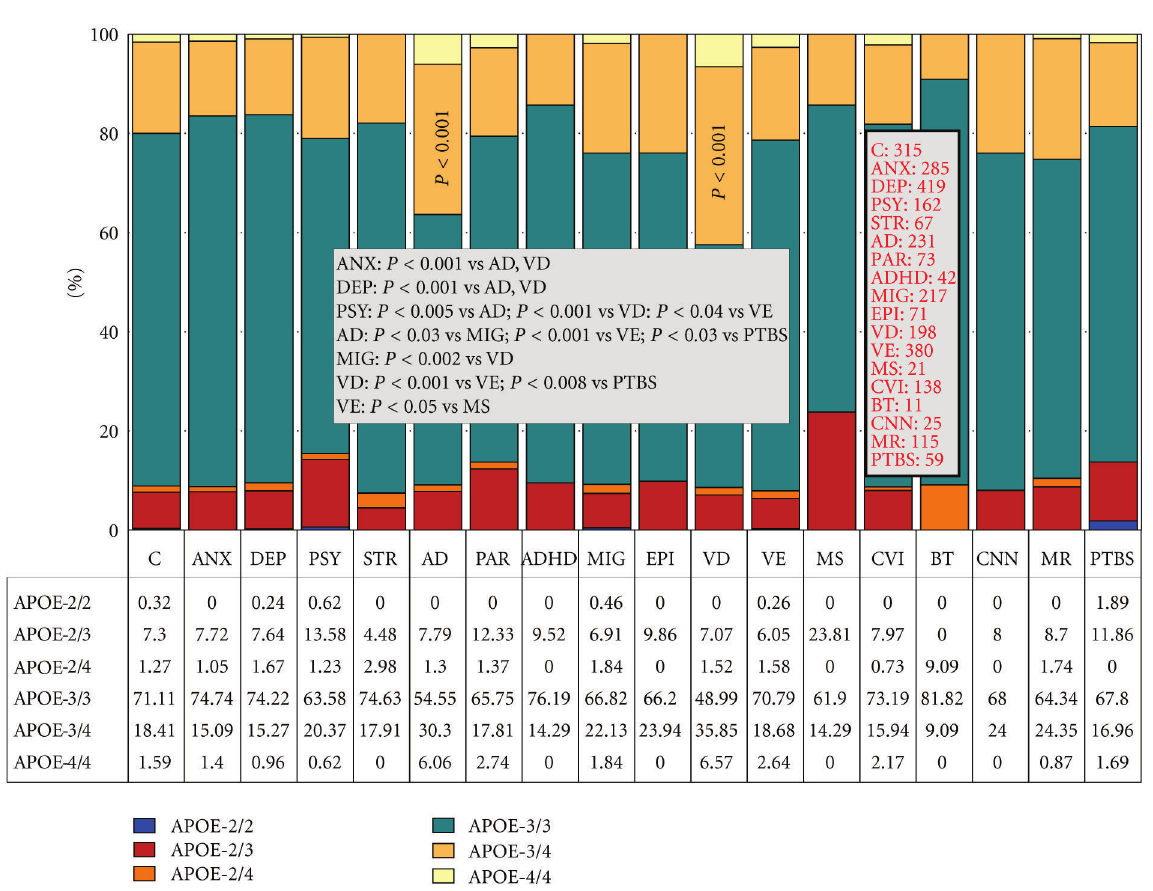
Figure 1: Distribution and frequency of APOE genotypes in patients with CNS disorders. C: controls; ANX: anxiety; DEP: depression; PSY: psychotic disorders; STR: stroke; AD: Alzheimer’s disease; PAR: Parkinson’s disease; ADHD: attention-deficit hyperactivity disorder; MIG: migraine; EPI: epilepsy; VD: vascular dementia; VE: vascular encephalopathy; MS: multiple sclerosis; CVI: cerebrovascular insu ffi ciency; BT: brain tumors; CNN: cranial nerve neuropathies; MR: mental retardation; PTBS: posttraumatic brain injury syndrome. Source: R. Cacabelos. CIBE Database. EuroEspes Biomedical Research Center, Institute for CNS Disorders, Coru˜na,